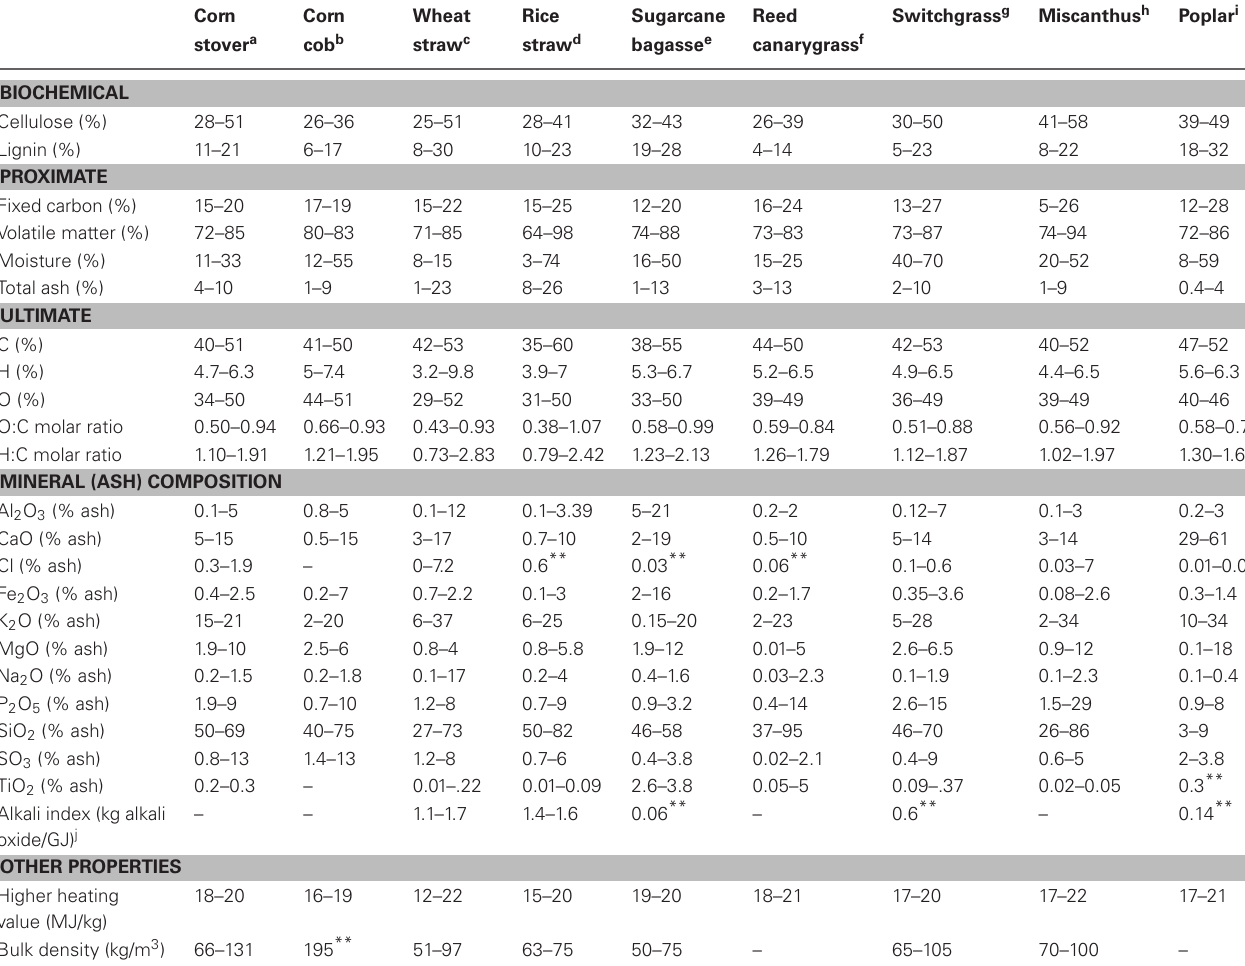
Table 2 | Ranges of key thermochemical properties in several biomass feedstocks as summarized from literature